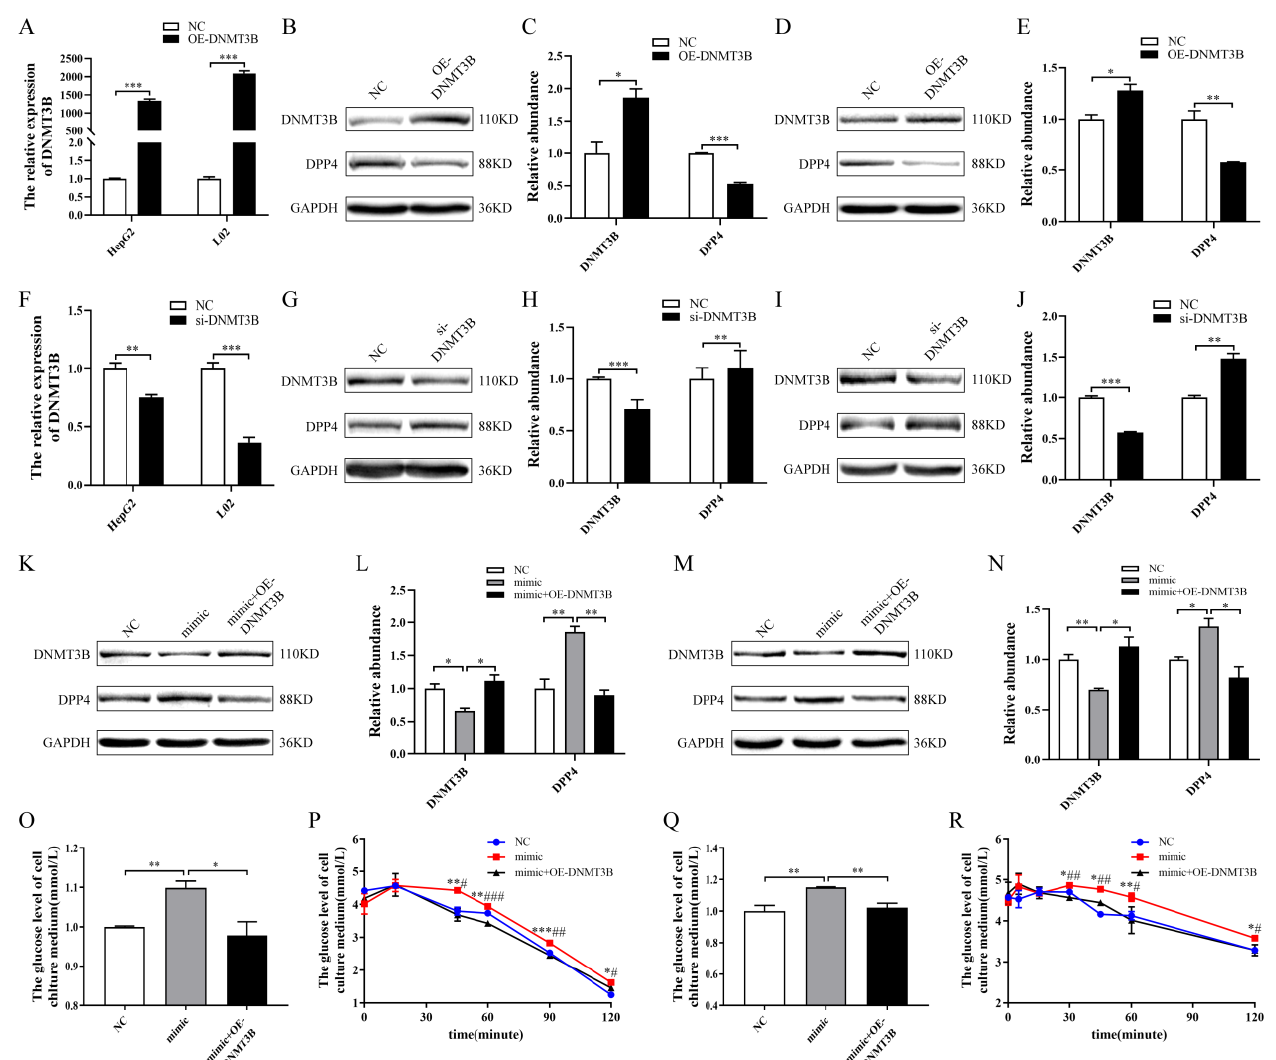
Figure 4. Rescue assay of HepG2 and L02 cells. ( A ) The mRNA expression of DNMT3B in HepG2 and L02 cells when 4 µg/mL and 1 µg/mL concentrations of DNMT3B-overexpression plasmid were used, respectively. ( B – E ) The protein expressions of DNMT3B and DPP4 in HepG2 and L02 cells after the overexpression of DNMT3B. ( F ) The mRNA expression of DNMT3B in HepG2 and L02 cells when 80 nM and 40 nM of the DNMT3B interference fragments were used, respectively. ( G – J ) The protein expressions of DNMT3B and DPP4 in HepG2 and L02 cells after the downregulation of DNMT3B. ( K – N ) The protein expressions of DNMT3B and DPP4 in HepG2 and L02 cells after over- expressing miR-548ag and upregulating DNMT3B simultaneously. ( O , P ) The glucose consumption and insulin sensitivity in HepG2 cells after overexpressing miR-548ag and upregulating DNMT3B simultaneously. ( Q , R ) The glucose consumption and insulin sensitivity in L02 cells after overex- pressing miR-548ag and upregulating DNMT3B simultaneously. (The p -values obtained in the t -test and non-parametric rank sum test are indicated. The data are presented as mean ± SEM. * p < 0.05, ** p < 0.01, and *** p < 0.001 indicate a significant difference, Figure P and Figure R, mimic group vs. NC group; * p < 0.05, ** p < 0.01, and *** p < 0.001 indicate a significant difference, mimic group vs. mimic + ad-DNMT3B group; # p < 0.05, ## p < 0.01, and ### p < 0.001 indicate a significant difference).